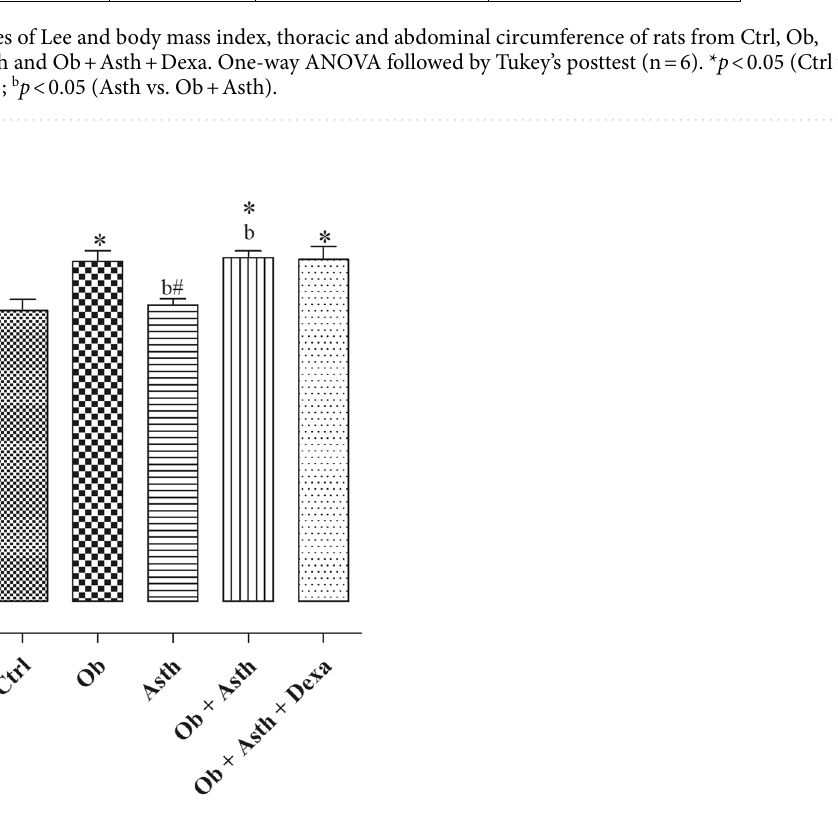
Figure 3. Evaluation of body mass index of rats from Ctrl, Ob, Asth, Ob + Asth and Ob + Asth + Dexa. One-way ANOVA followed by Tukey’s posttest (n = 6). * p < 0.05 (Ctrl vs. Ob, Ob + Asth); b p < 0.05 (Asth vs. Ob +